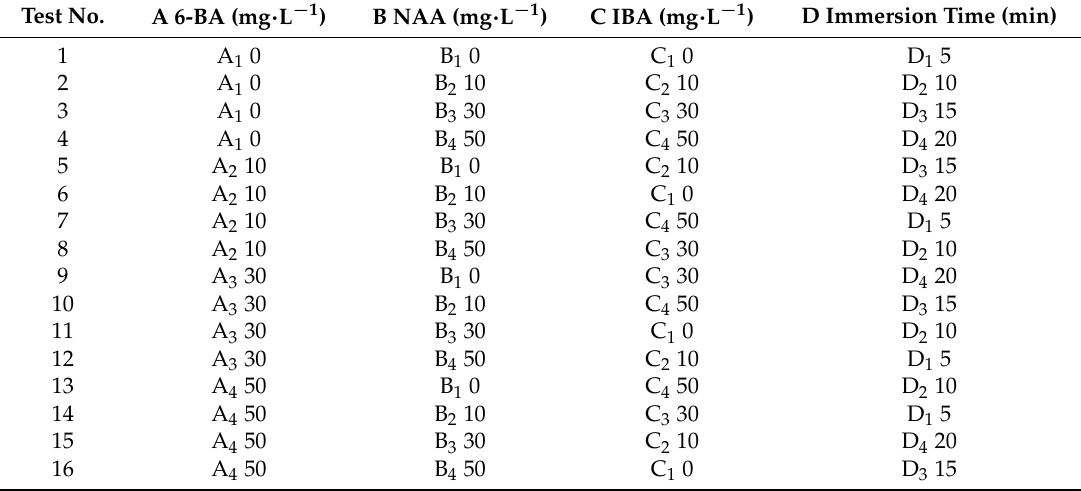
The L 16 (4) 4 orthogonal experimental design including different growth hormone combinations and treatment durations. 6-BA: 6-benzylaminopurine; NAA: 1-naphthaleneacetic acid; IBA: indole-3-butyric